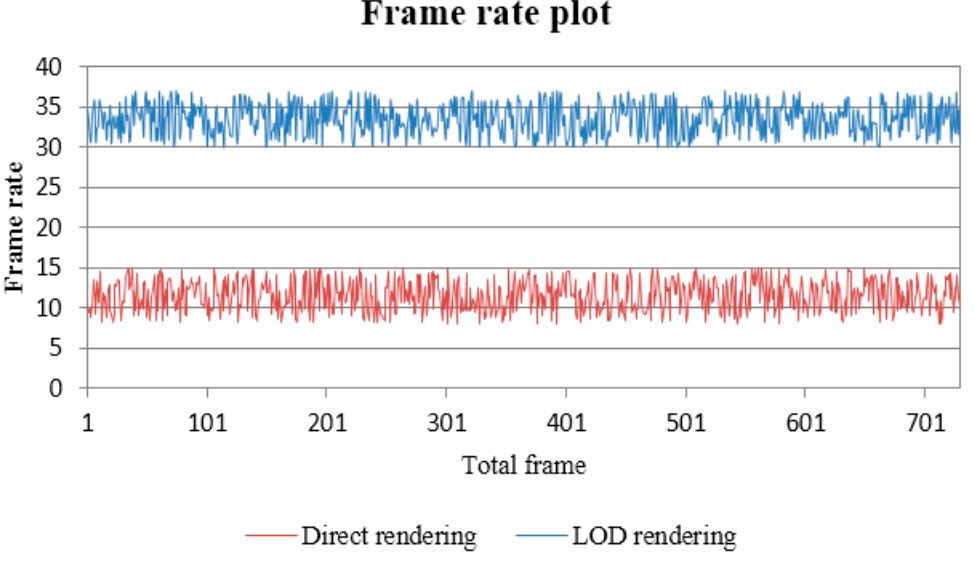
Figure 20. Comparison of the frame rates between rendering the origin model and LOD models.